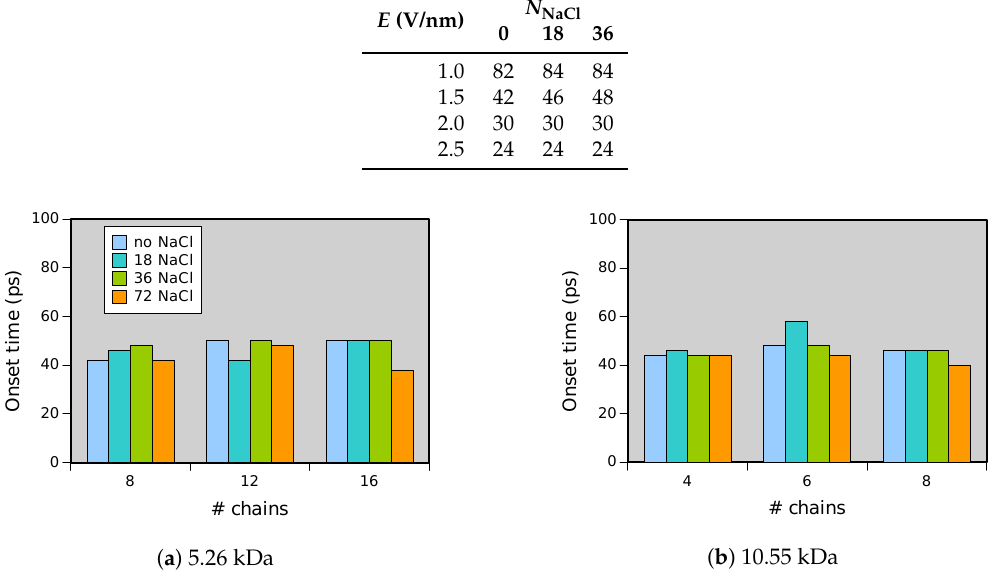
Figure 15. Production times at which the total mass transfer through the plane at z = 20 nm exceeded 2000 Da vs. number of chains for different numbers of NaCl ion pairs (see the legend) under 1.5 V/nm.